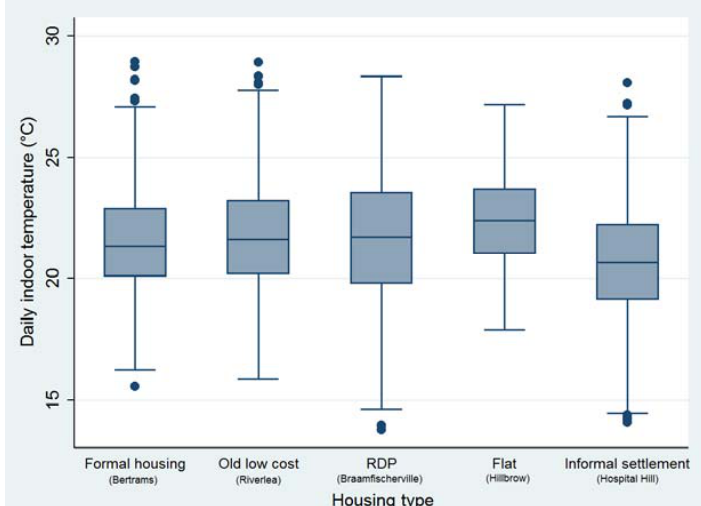
Figure 2. Box plot of daily indoor temperature by housing type. Top whisker: greatest value excluding outliers; Upper quartile: 25% of the data greater than this value; Median: 50% of data is